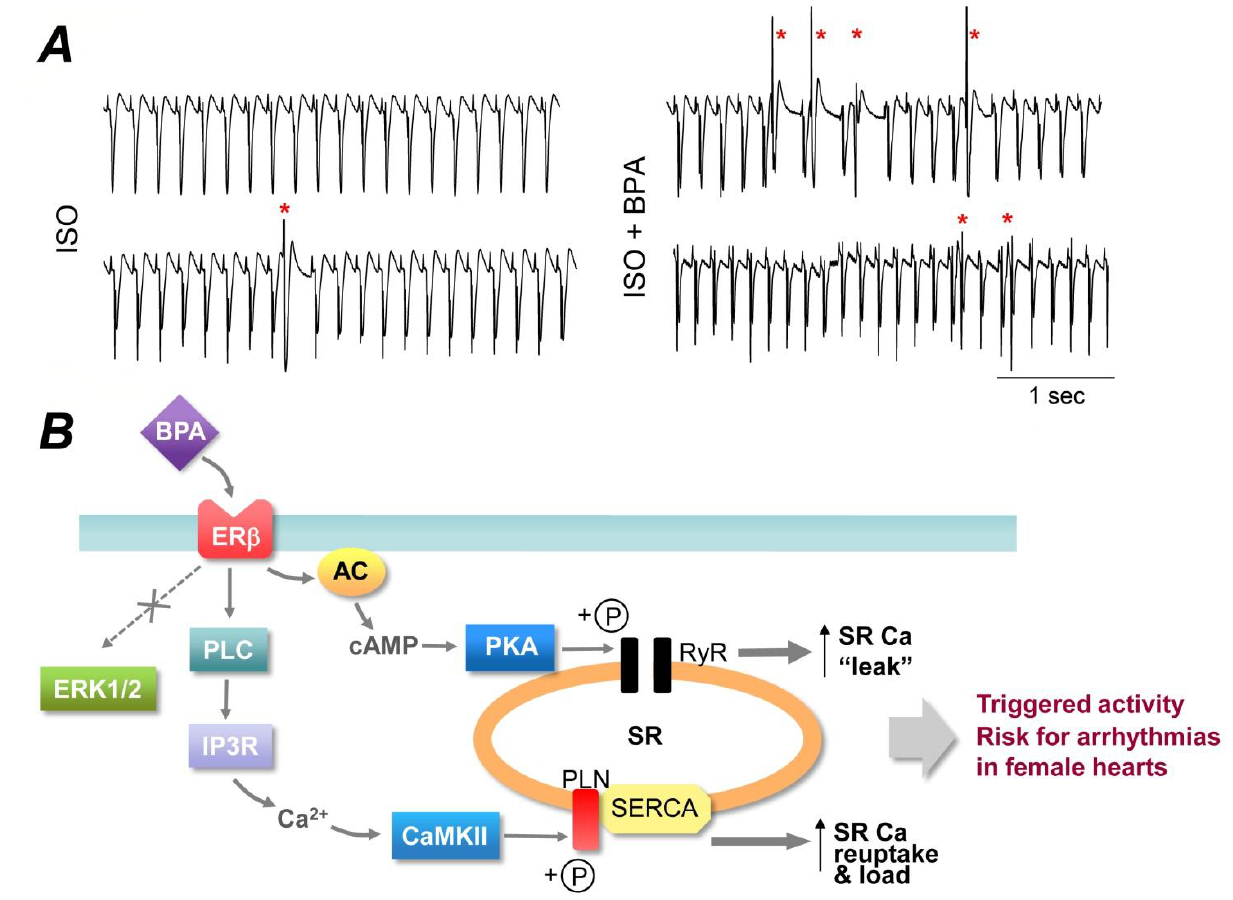
Figure 1. ( A ). Acute exposure to low-dose BPA promoted the development of ventricular arrhythmias under catecholamine-induced stress in female rat hearts. Shown are example surface ECG traces from female rat hearts under 10 −8 M isoproterenol (ISO) alone or in the presence of 10 −9 M BPA and ISO. Red asterisks indicate premature ventricular beats. Experimental methods are as described in [39]. Unpublished data by X Gao and H-S Wang. ( B ). Schematic illustration of the rapid signaling mechanism of BPA in female rat ventricular myocytes. Adopted from [24] with license